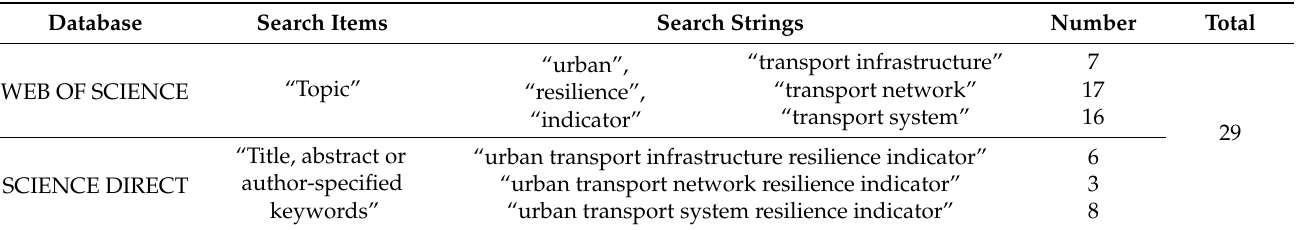
Table 2. Searching details and number of